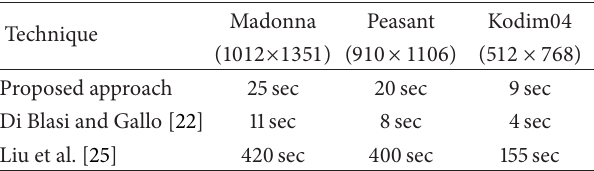
Table 1: Execution time (seconds) of the considered approaches on the test images.